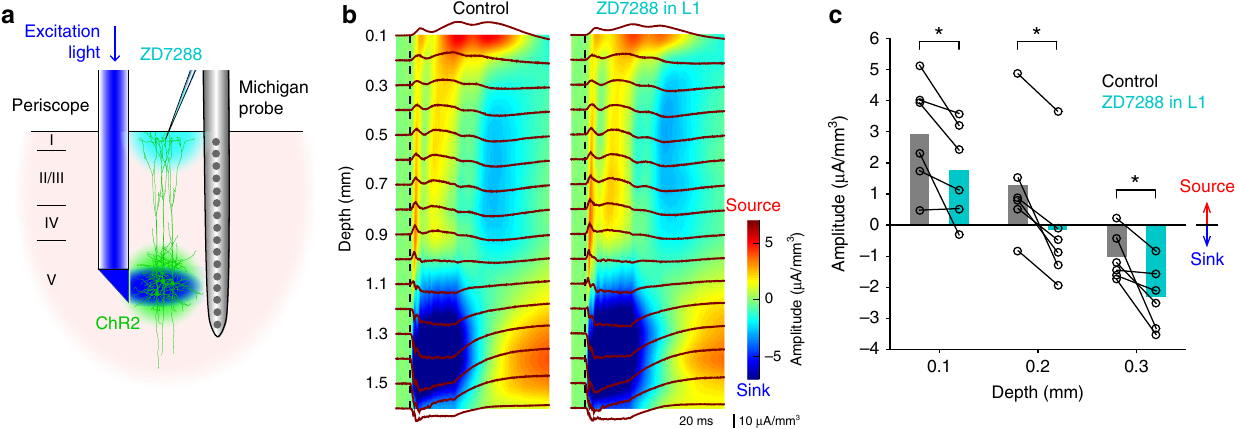
Fig. 2 I h contributes to the generation of passive current in L1. a Schematic diagram of the experiment. b CSD pro fi les of evoked potentials before ( left ) and after application of 500 μ M ZD7288 to the cortical surface ( right ), averaged over 100 measurements. c Summary of the CSD amplitude at 100 to 300 μ m below the pia before and after ZD7288 application at the cortical surface (all p < 0.05, Wilcoxon signed-rank